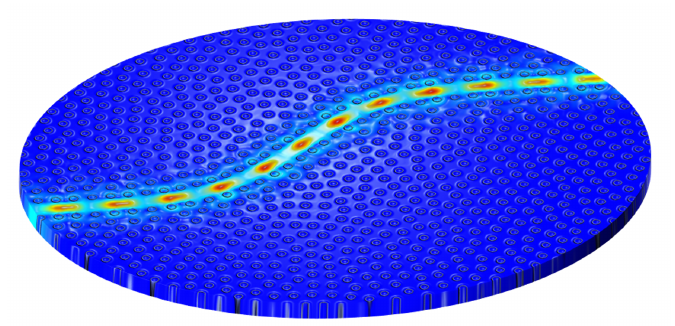
Figure 7. Snapshot of the elastic field profile at an incident wave frequency of 0.52 GHz for the waveguide shown in Figure 4a, with a finite height of 1 µ m. The color scale represents the magnitude of the elastic field while the local disturbance is proportional (with orders of magnitude larger, for visualization) to the actual disturbance due to the elastic field traveling through the